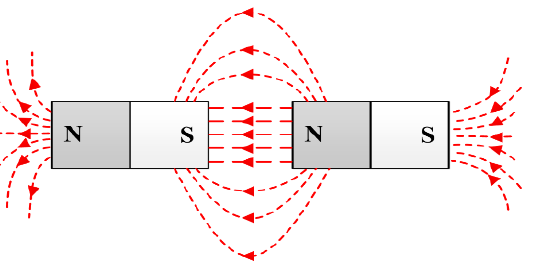
Figure 1. Distribution of magnetic lines. ( a ) Solenoid; ( b ) bar magnets.